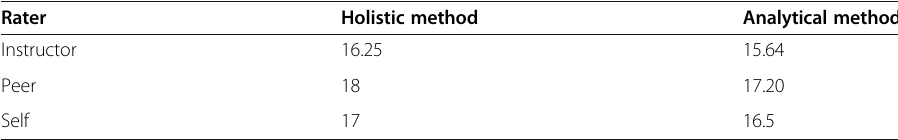
Table 2 Independent task mean scores